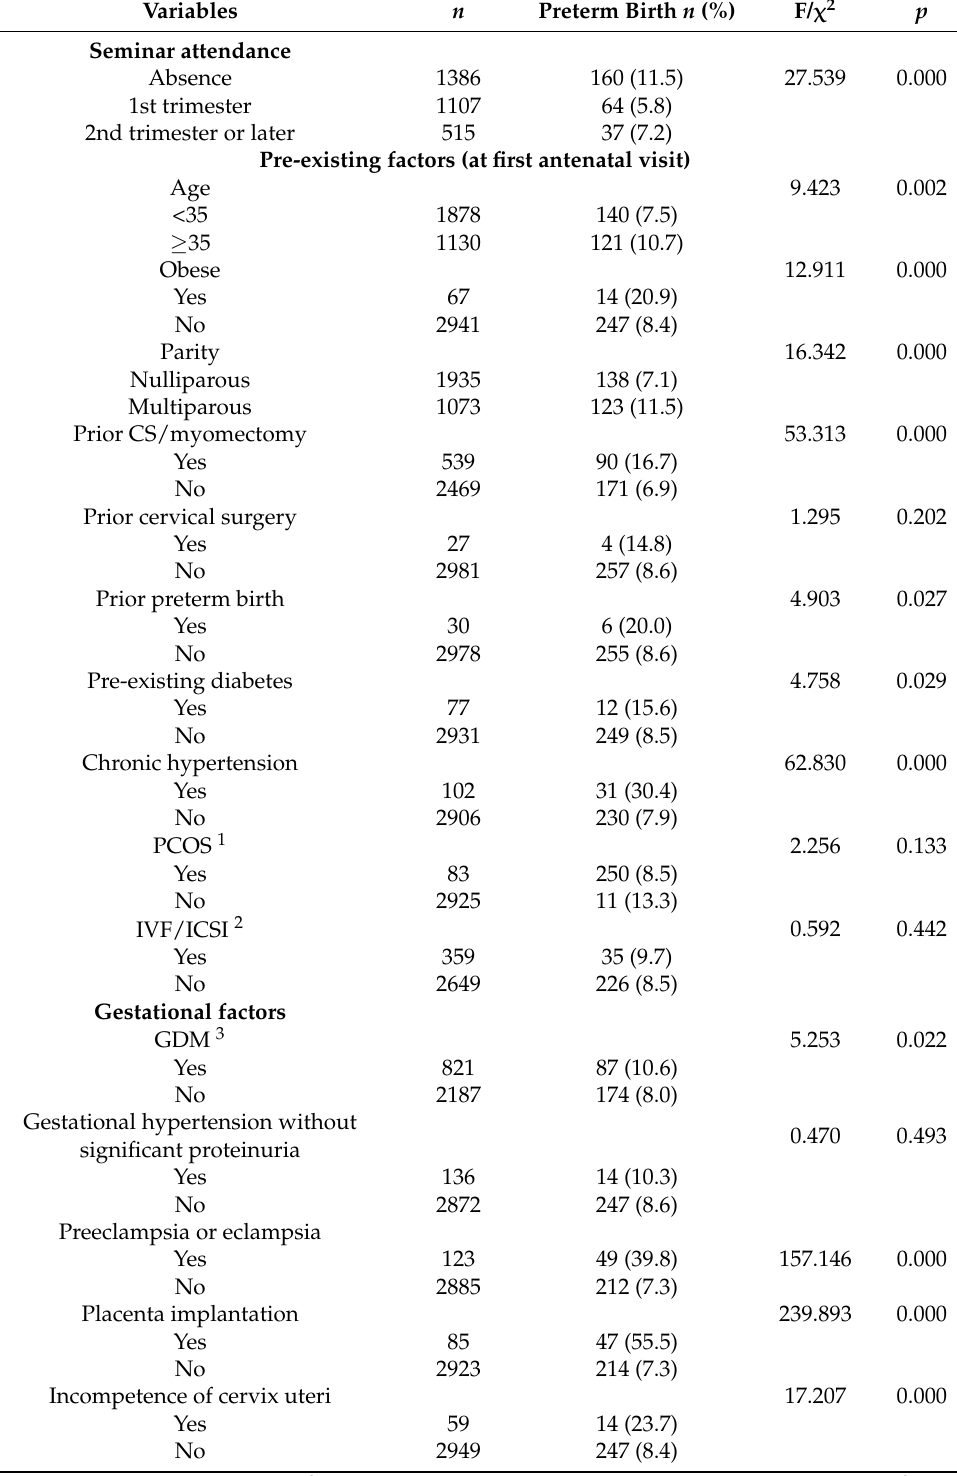
Table 2. Preterm birth rates stratified by maternal